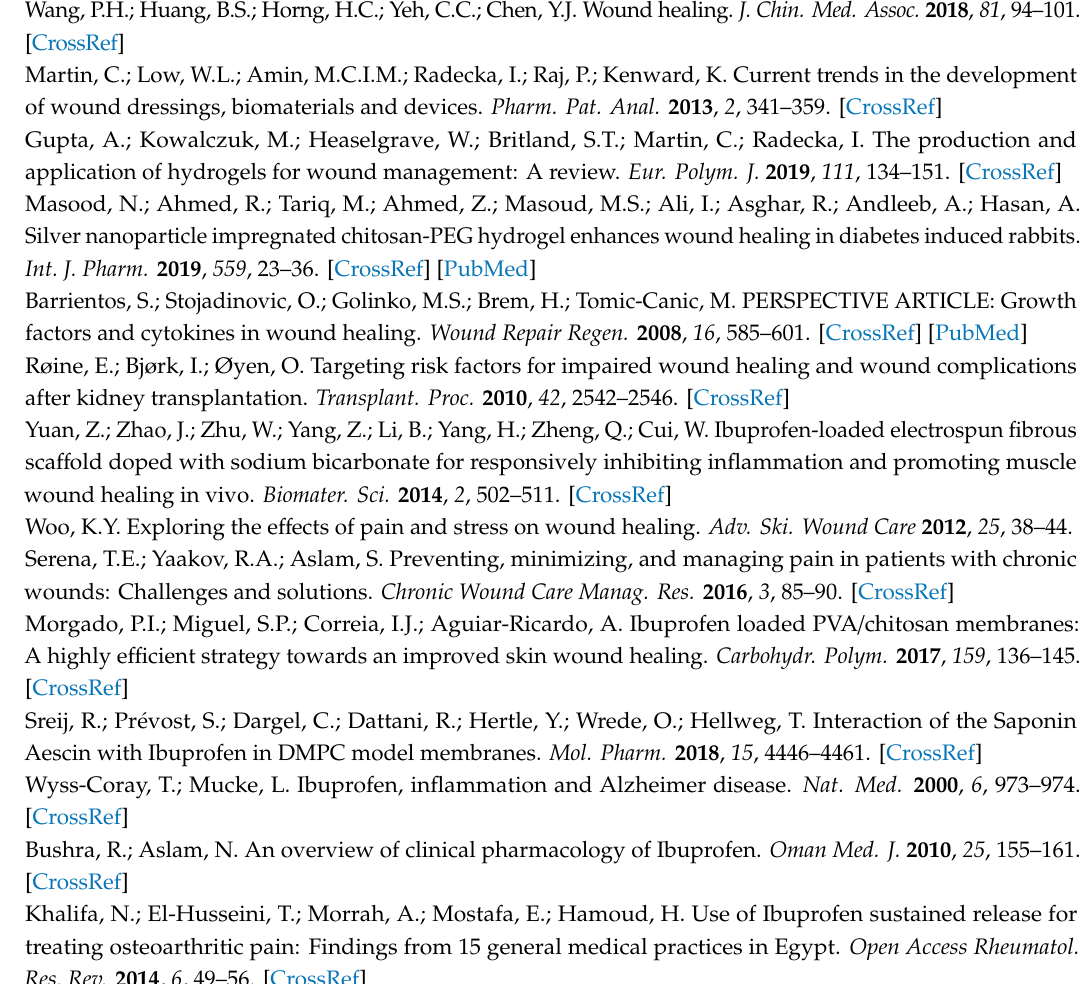
Figure S1: Number average molecular weight (Mn) of PNIPAM-NH2 from GPC measurement, Figure S2: SEM images of lyophilized (a) Hep-PNIPAM-b1 hydrogel and (b) Hep-PNIPAM-b2 hydrogel, and (C) Hep-PNIPAM-b3 hydrogel. Figure S3: Fluorescence images of the HaCaT cells stained with calcein AM / PI with and without Hep-PNIPAM treatment. Figure S4: The standard calibration curve of (a) TNF- α , (b). PGE2 and(c)